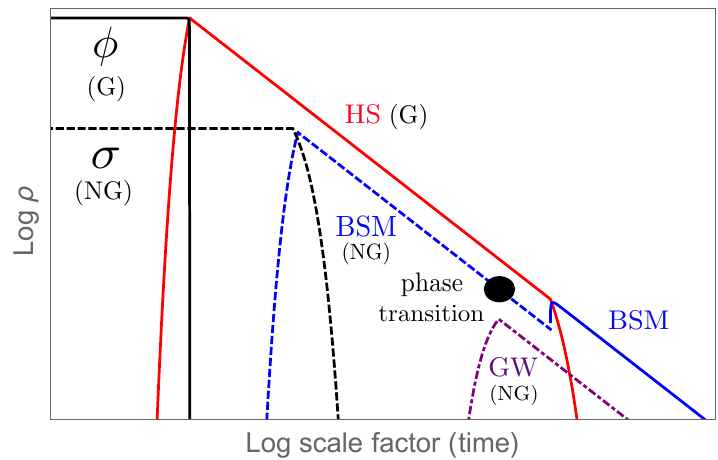
Figure 1 . Cosmological history of the CMB and GWB production, along with their fluctuations. The inflaton field (solid black) carries a Gaussian (G) fluctuation and reheats a hidden sector (HS) (red). A separate field σ (dashed black) carries a non-Gaussian (NG) fluctuation and reheats the BSM sector (blue) where the PT occurs. Following the PT, the HS decay into the BSM sector which eventually gives rise to the CMB. Depending on the NG of σ and the size of f BSM , the fractional energy density of the BSM sector, the GW signal (purple) can have a large NG while CMB is almost Gaussian. The plot is adapted and modified from